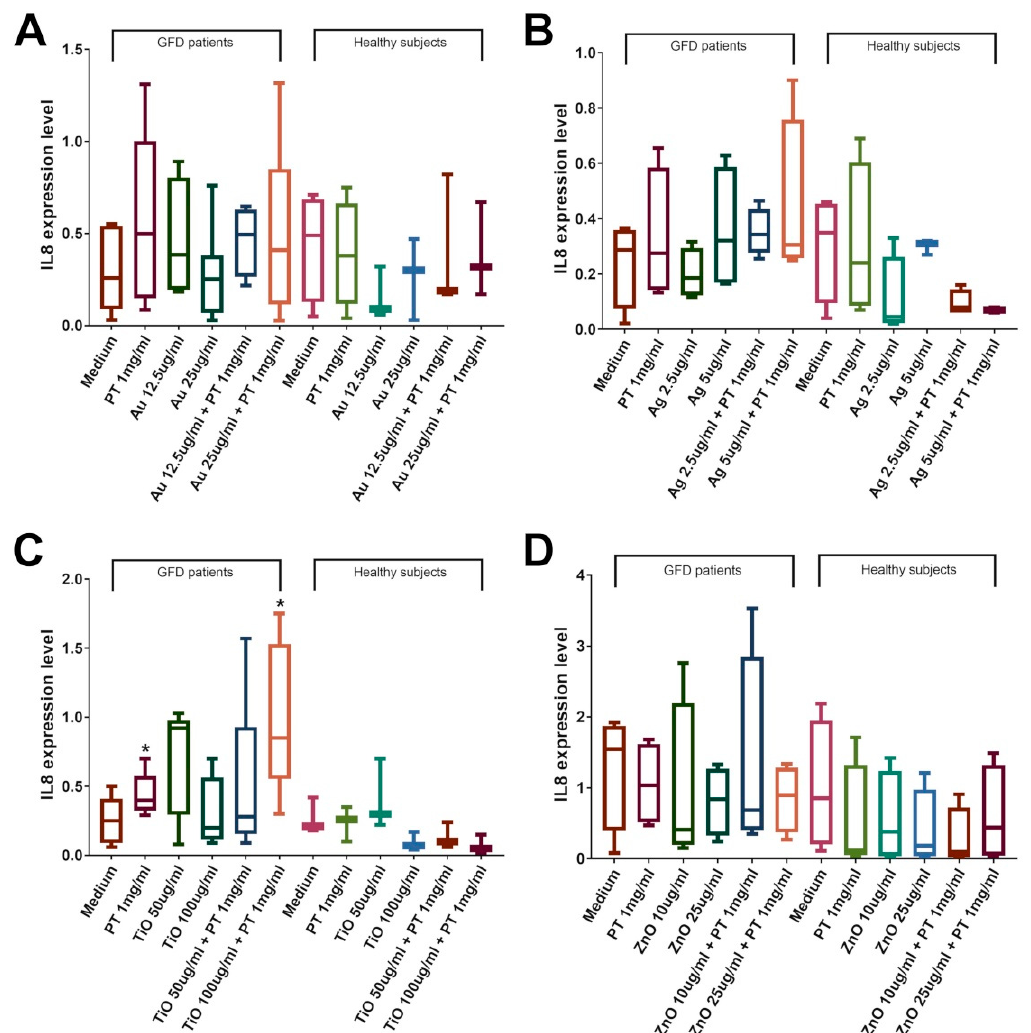
Figure 10. IL-8 expression in CeD patients on a GFD and healthy controls. Significance versus untreated biopsies is indicated above each column (* p < 0.05), whereas versus PT is represented by bars. Duodenal biopsies stimulated 4 h with PT 1 mg/mL ± ( A ) AuNPs 12.5/25 µ g/mL (GFD n = 6; Healthy n = 3); ( B ) AgNPs 2.5/5 µ g/mL (GFD n = 6; Healthy n = 4); ( C ) TiO2NPs 50/100 µ g/mL (GFD n = 7; Healthy n = 4); ( D ) ZnONPs 10/25 µ g/mL (GFD n = 5; Healthy n = 4). Box plots represent median, 25th, and 75th percentiles. Whiskers indicate 5th and 95th percentiles.